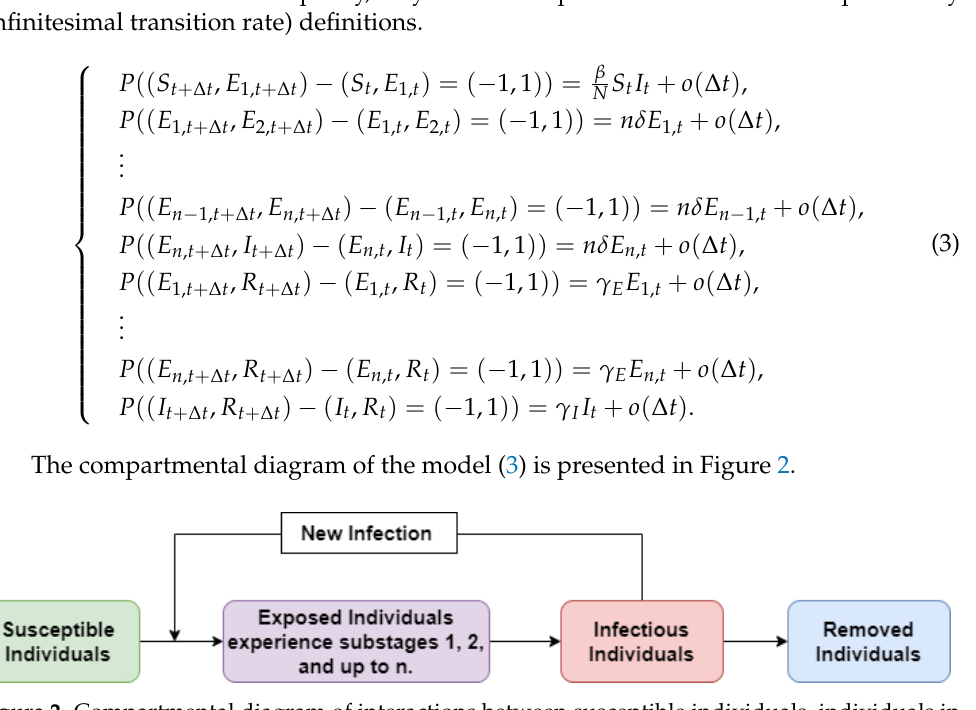
Figure 2. Compartmental diagram of interactions between susceptible individuals, individuals in sub exposed stage 1, · · · , individuals in sub exposed stage n , infectious individuals and removed in-